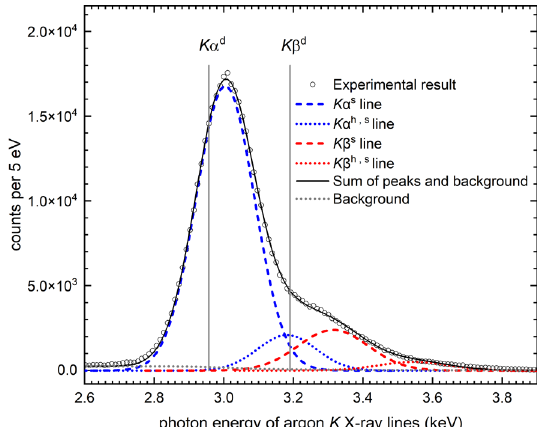
Figure 1. Measured spectra of X-rays emitted from argon target in the collisions with 197-MeV/u Xe 54+ ions, obtained by the Si(Li) detector at the 90° observation angle. The measured data are represented by open circles, while the fitted transitions are represented by dashed curves. The fitted background is shown as gray dotted line.